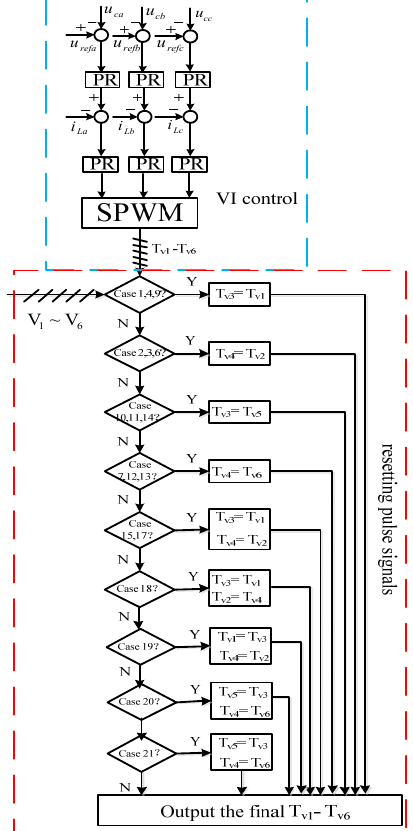
Figure 5. The proposed control strategy flow figure.